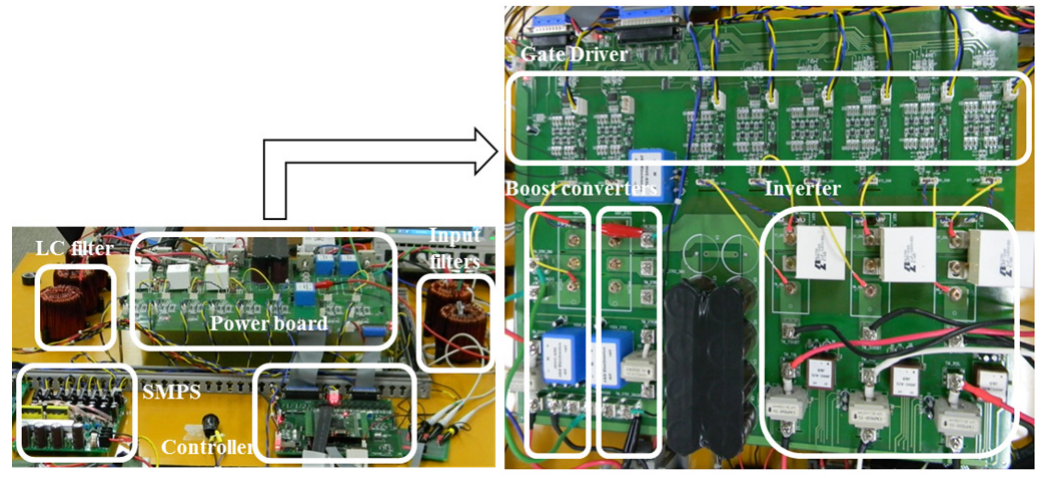
Figure 17. Experimental setup of the 10kW two-string PV